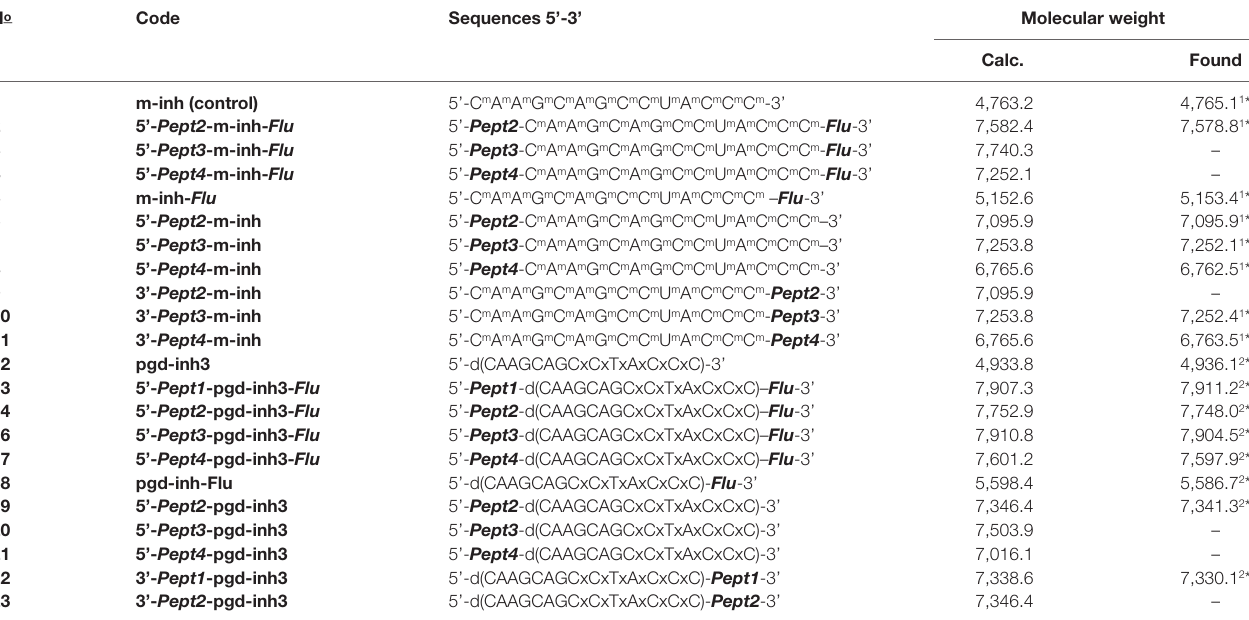
TABLE 2 | The peptide conjugates of RNase P inhibiting oligonucleotides m-inh and pgd-inh3 . N o _